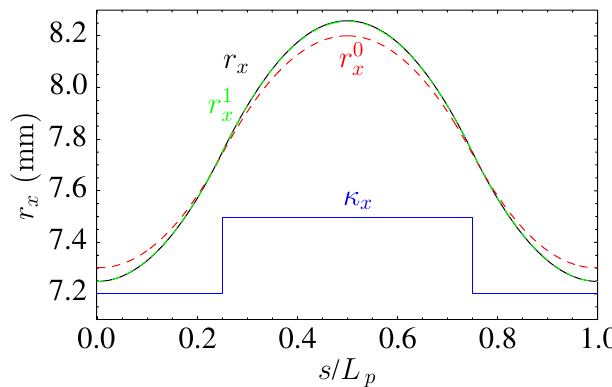
FIG. 4. (Color) For solenoidal focusing: converged matched envelope solution (black) with r r 0 (red), and the second iteration r 1 x